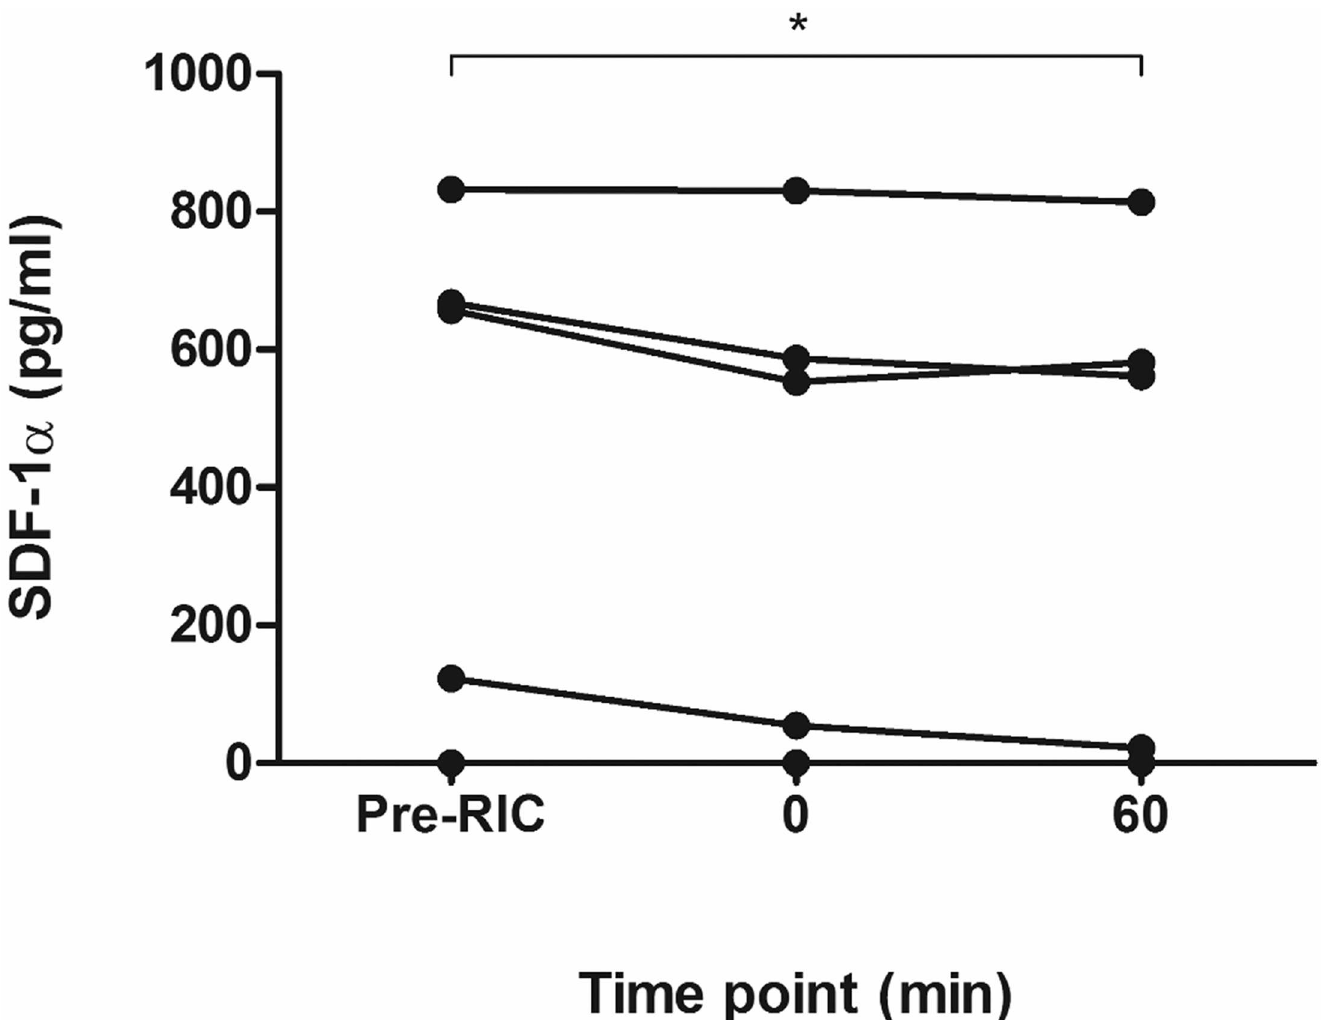
Fig 10. Effect of RIC on intact SDF-1 α in humans. Plasma levels of full-lengthSDF-1 α (quantified using HCI.SDF1 α ELISA), decreased significantly in healthymale volunteers subjectedto RIC.